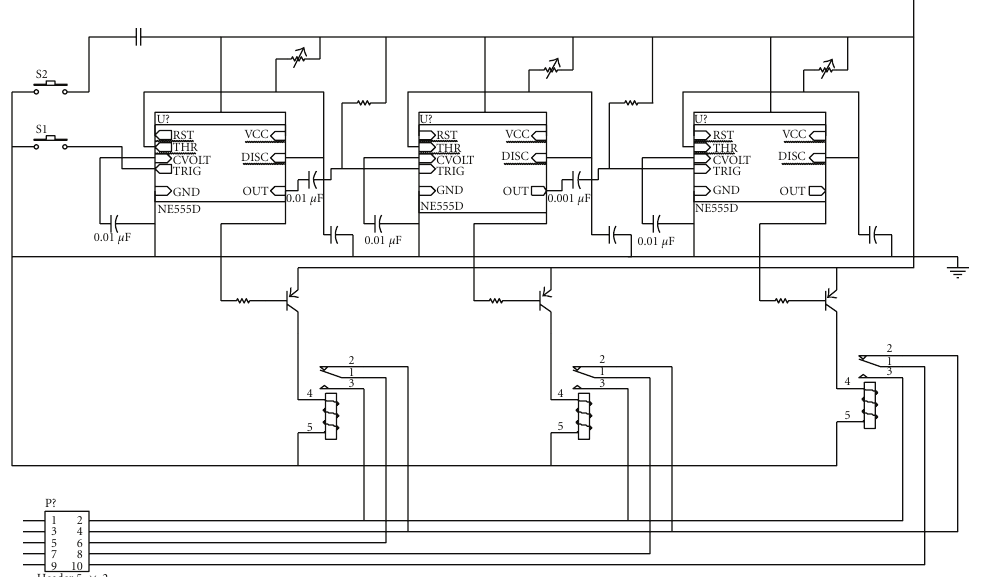
Figure 2: Control circuit diagram of sequential segmenting